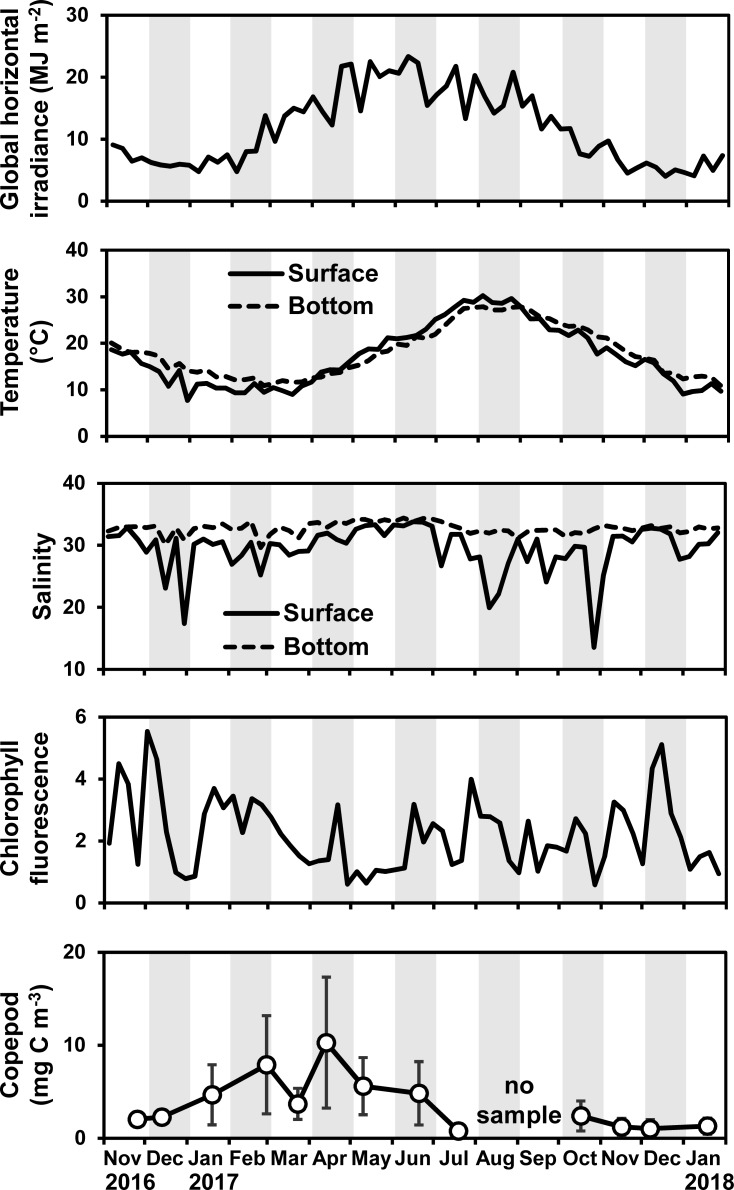
Temporal variations in environmental parameters.Chlorophyll fluorescence was averaged throughout the water column. Error bars in the copepod density indicate SD.